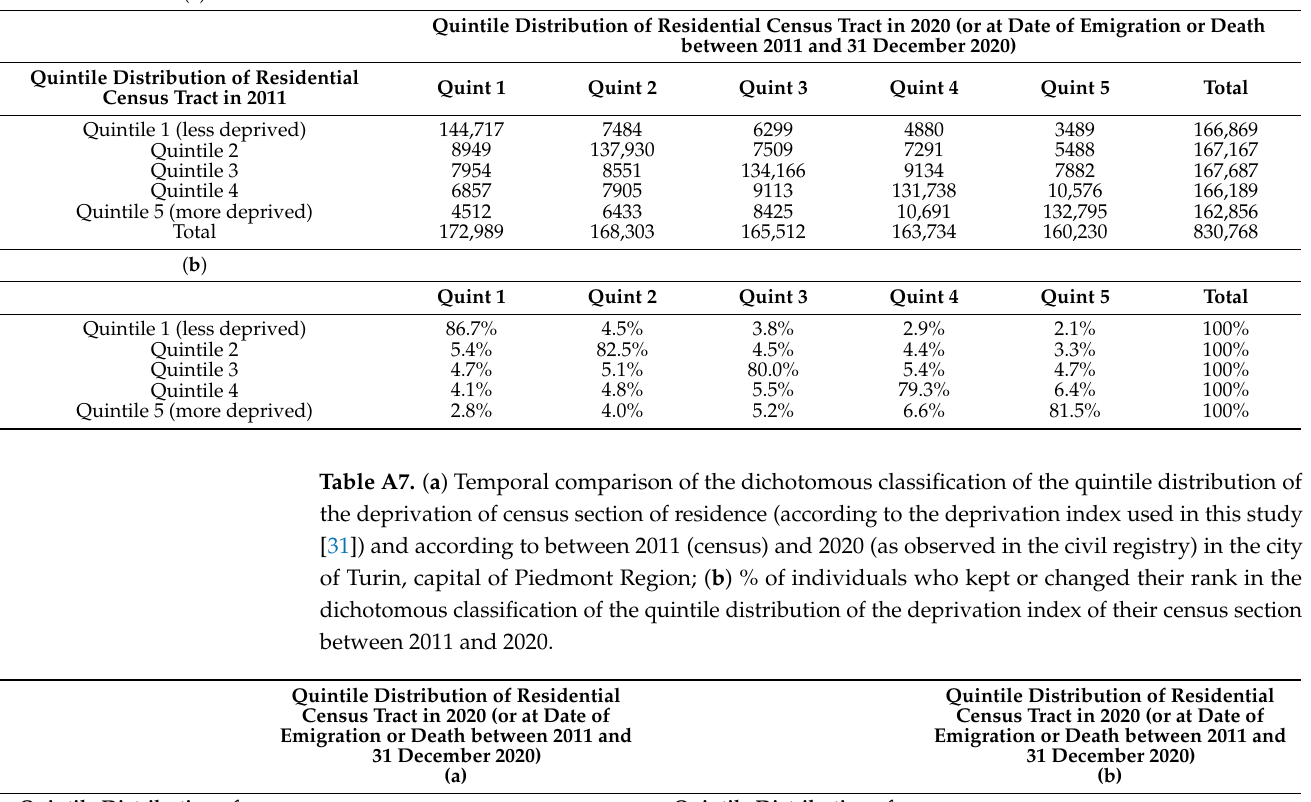
Table A6. ( a ) Temporal comparison of the quintile distribution of the deprivation of census section of residence (according to the deprivation index used in this study [31]) between 2011 (census) and 2020 (as observed in the civil registry) in the city of Turin, capital of Piedmont Region. ( b ) % of individuals who kept or changed their quintile rank in the distribution of the deprivation index of their census section between 2011 and 2020.